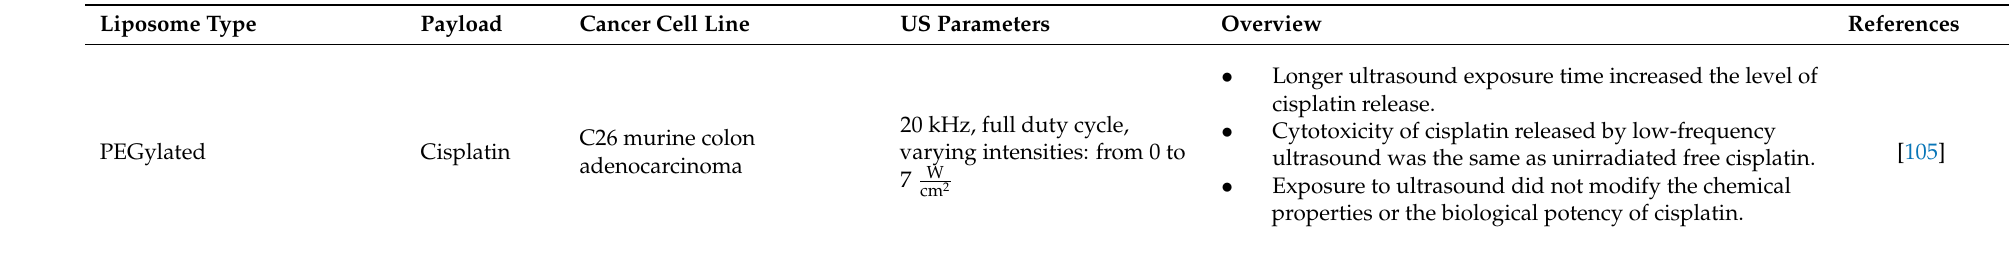
Table 4. In vitro cell studies using liposomal drugs and